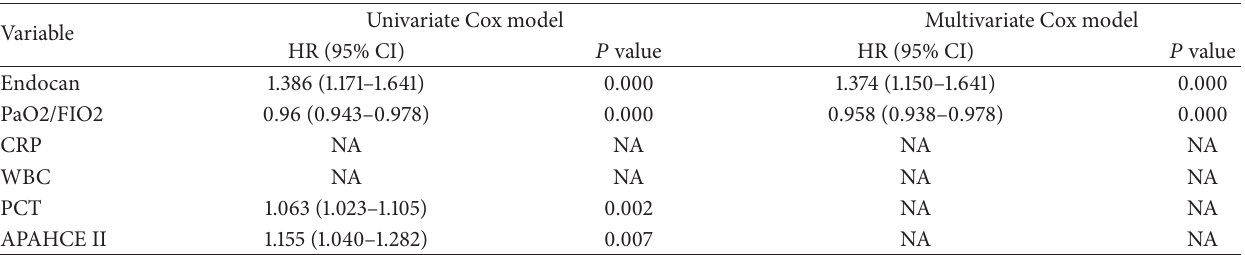
Table 3: Cox proportional hazards models for mortality prediction by biomarkers and severity scores.